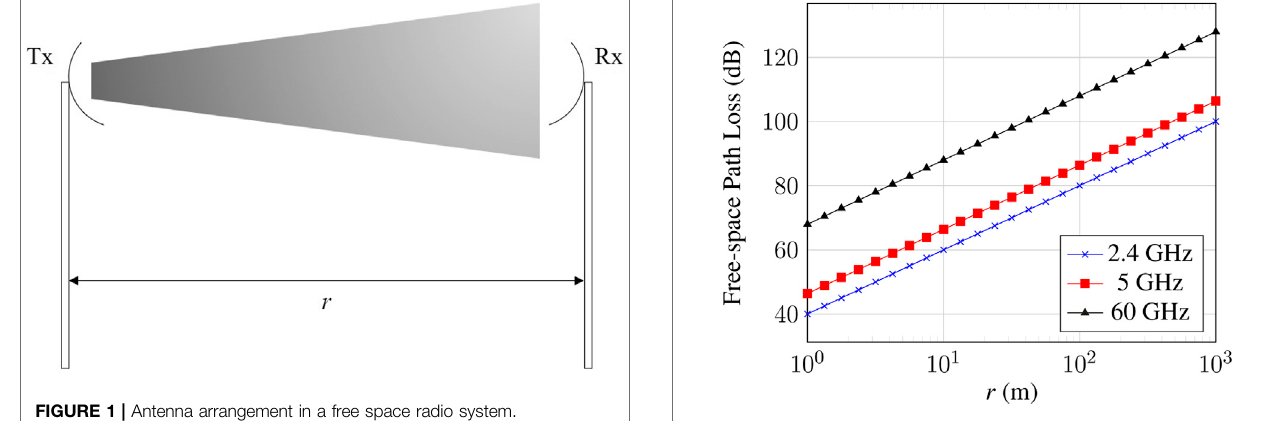
FIGURE 2 | Free-space loss comparison between signals operating at 2.4, 5 and 60